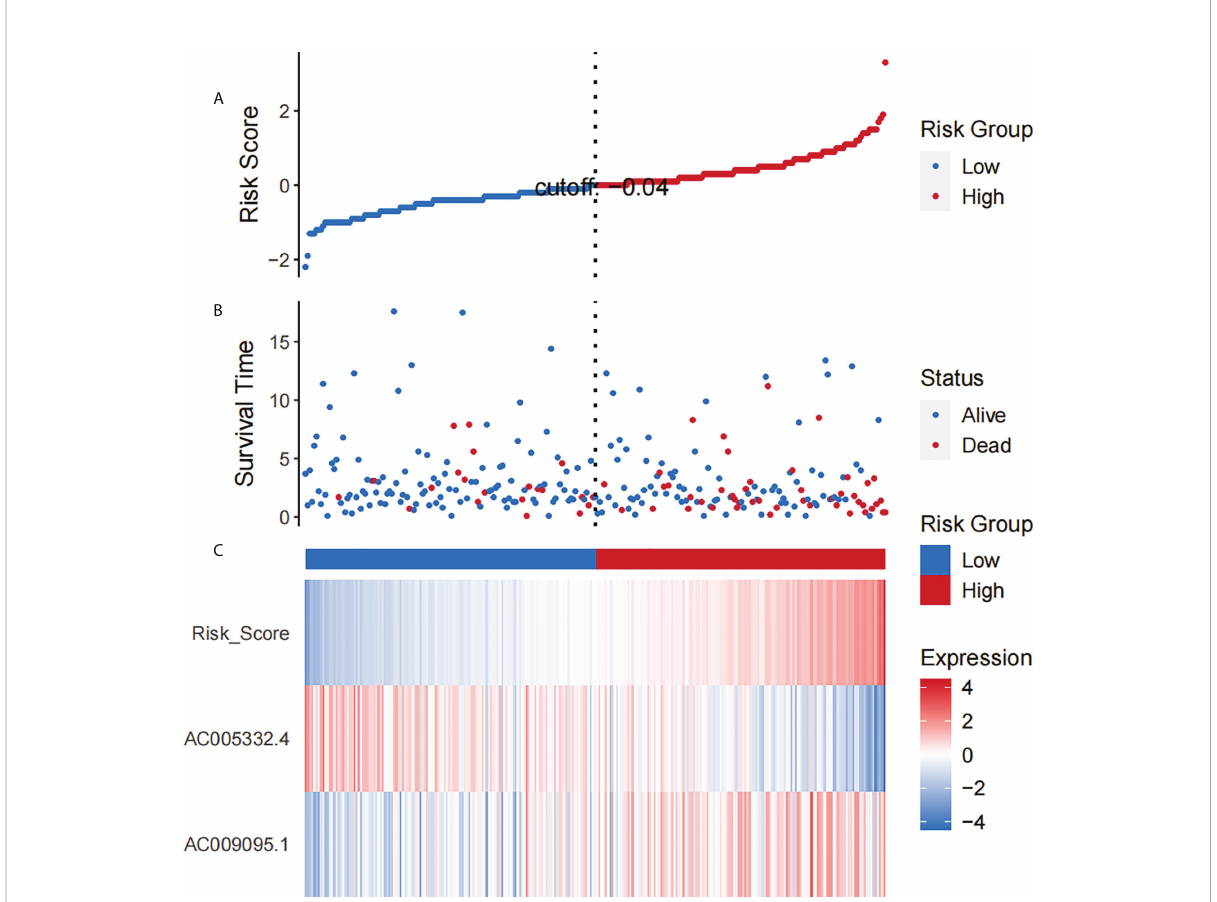
FIGURE 3 The analysis results which belong to CESC patients ’ NRL signature. (A) The risk scores which belong to two groups. (B) The CESC patients ’ survival time. (C) Heat map of the expression of the two NRLs and risk scores. The upward trend from low to high levels respectively corresponds to the colors which are from green to